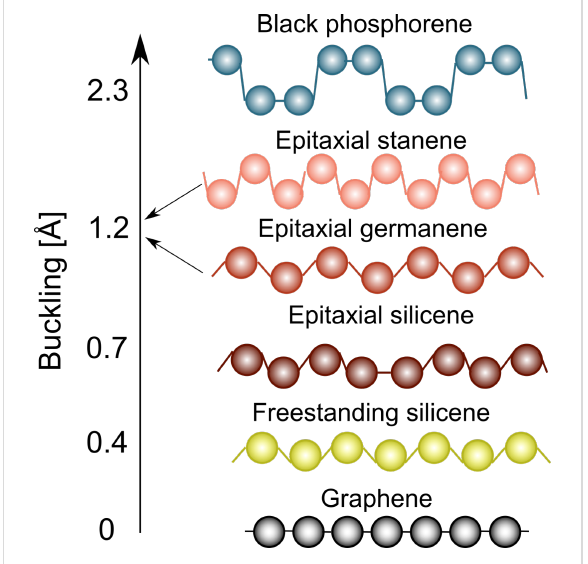
Figure 1: Illustration of the increasing buckling of different elemental 2D materials.